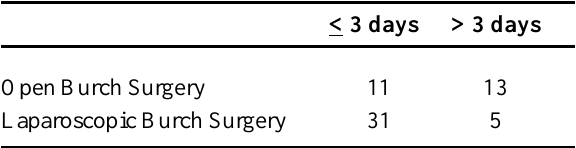
Table 4 – Hospitalization time of patients undergoing Burch surgery (mean 3 days) ( c 2 = 13.25, p = 0.002).